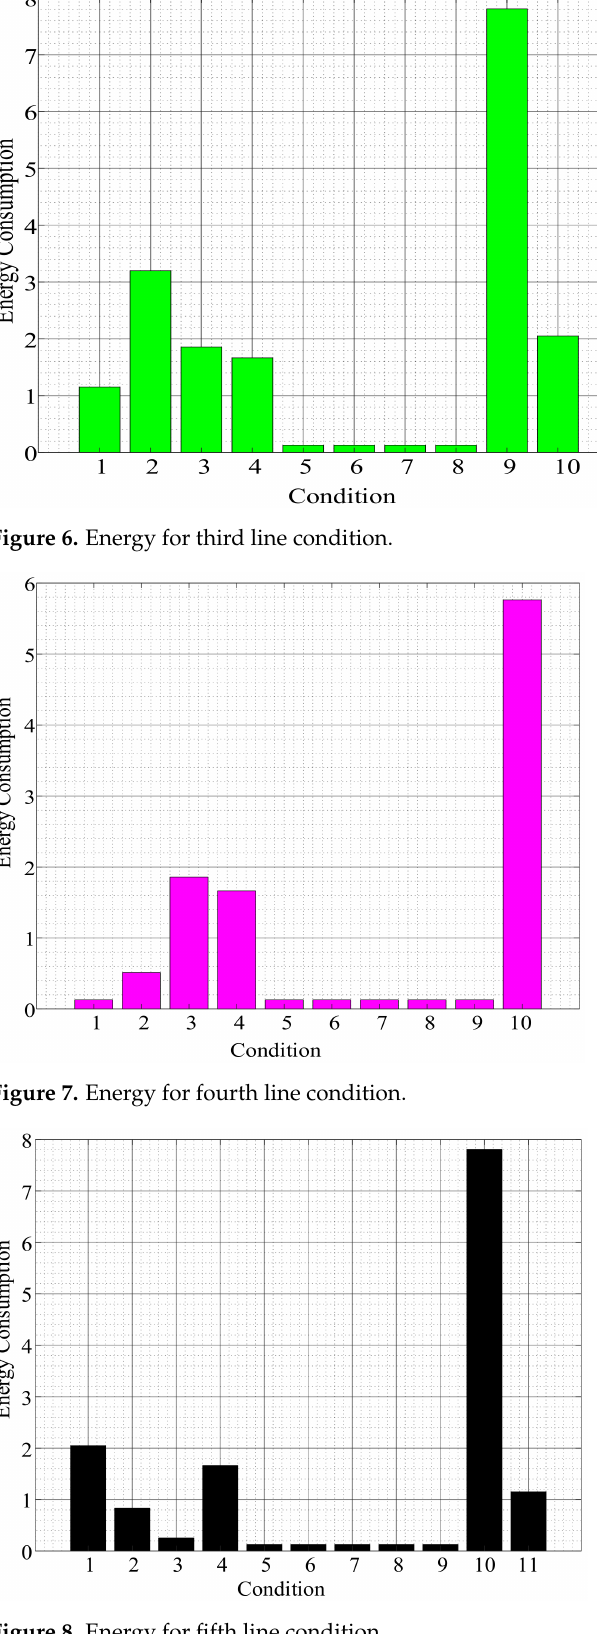
Figure 8. Energy for fifth line